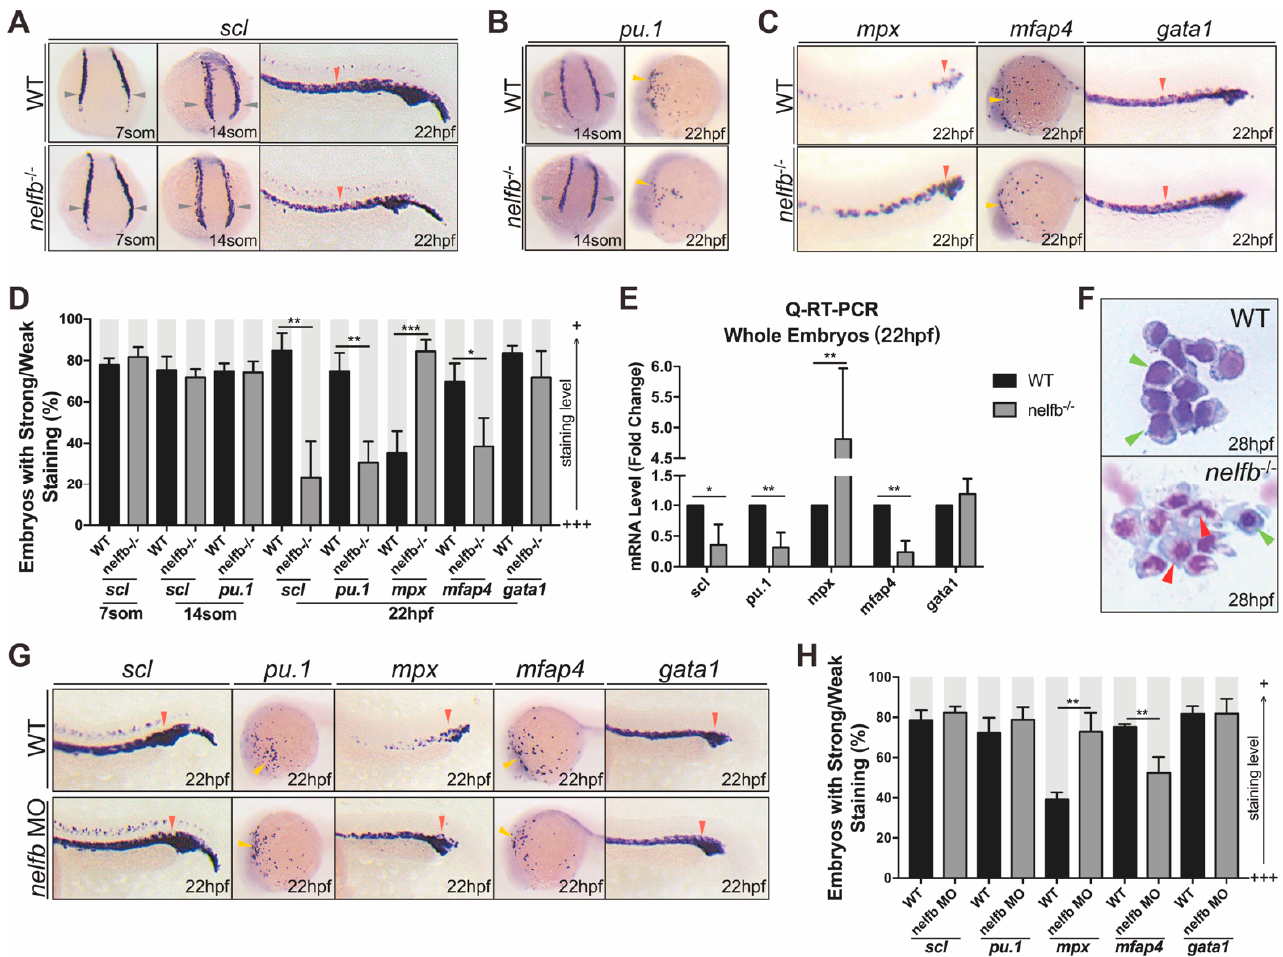
Figure 2. Nelfb deficiency leads to accelerated granulocytic development during primitive hematopoiesis. ( A ) WISH for scl in WT and nelfb − / − embryos at 7-, 14-somite stages and 22 hpf. ( B ) WISH for pu.1 in WT and nelfb − / − embryos at 14-somite stage and 22 hpf. ( C ) WISH for mpx , mfap4, and gata1 in WT and nelfb − / − embryos at 22 hpf. ( D ) Quantification of WISH results in ( A – C ) ( n = 40–60 embryos per group). ( E ) Q-RT-PCR analysis of gene expression in nelfb − / − and WT embryos at 22 hpf. Gene expression is normalized to β -actin and presented as fold-change relative to WT. ( F ) May–Grünwald–Giemsa staining of peripheral blood in WT and nelfb − / − embryos at 28 hpf. Green arrowheads indicate precursors; red arrowheads indicate granulocytes. ( G ) WISH for scl , pu.1 , mpx , mfap4 , and gata1 in WT and nelfb morphants at 22 hpf. ( H ) Quantification of WISH results in ( G ) ( n = 20–40 embryos per group). All results are presented as the mean ± SD from three independent experiments ( t test, * for p < 0.05, ** for p < 0.01, *** for p < 0.001). Grey arrowheads, yellow arrowheads, and red arrowheads in ( A – C , G ), respectively, indicate ICM, ALPM, and PLPM. “+++” and “+” in ( D , H ) respectively represent strong staining and weak staining. WISH, whole-mount in situ hybridization; ICM, intermediate cell mass; ALPM, anterior lateral plate mesoderm; PLPM, posterior lateral plate